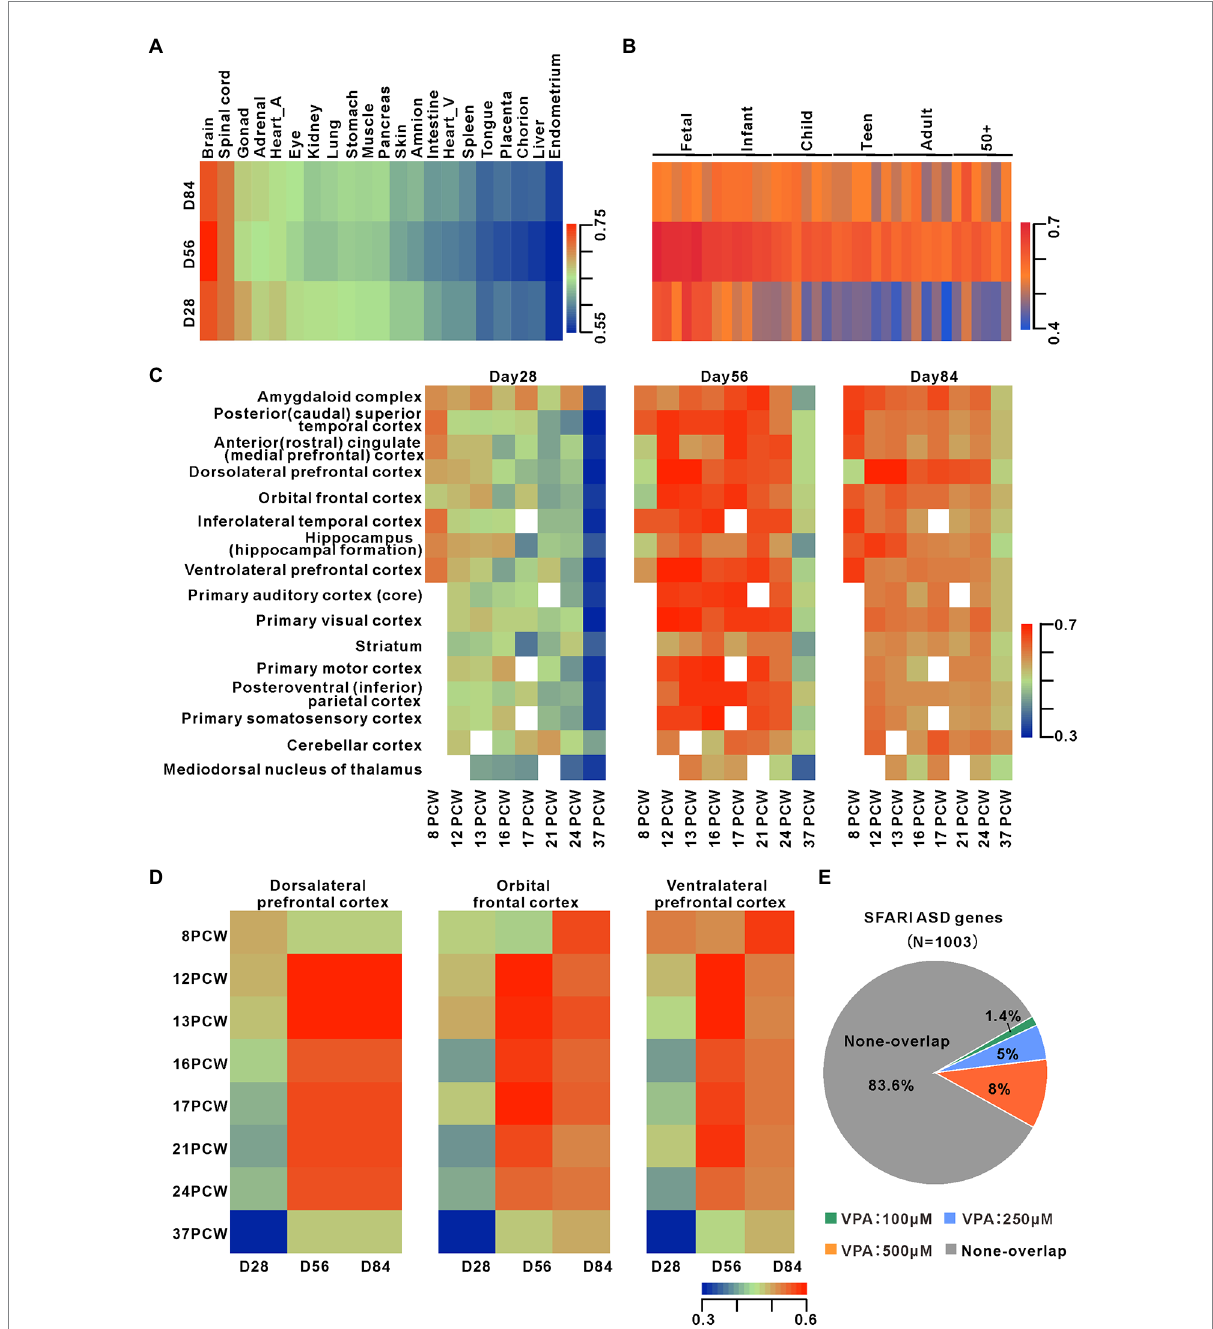
FIGURE 2 Transcriptomes comparison between dorsal forebrain organoids and human fetal brain Development. (A) Heatmap of Pearson’s correlation analysis of RNA-seq datasets from days 28 ( n = 6 organoids each), 56 ( n = 4 organoids each), and 84 ( n = 4 organoids each) organoids and datasets for 21 human fetal organs. The figure presented the mean values of biological replicates. (B) Pearson correlation heatmap among organoids at early stages and human dorsolateral prefrontal cortex samples from 6 life stages (Jaffe et al., 2015). (C) Pearson correlation heatmap among organoids and transcriptome datasets from 16 different cortical regions across 8 early human stages (http://www.brain-map.org/). (D) Pearsoncorrelationheatmap among organoids and transcriptome datasets from 3 different cortical subregions across 8 early human stages. (E) Overlap of DEGs during organoid development with ASD-related risk genes (from https://gene.sfari.org/autdb/HG_Home.do). The statistically significant overlapping genes were determined ( p < 0.001, chi-square